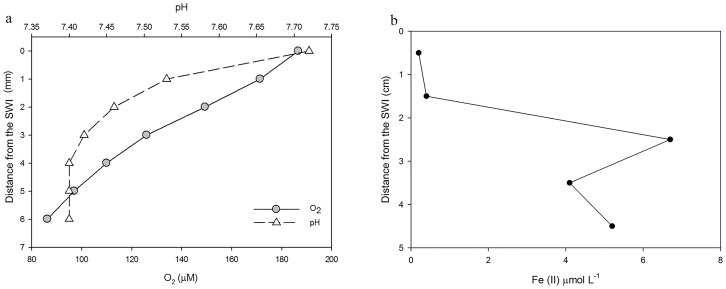
Geochemical parameters of the sampled sediments.a) pH and O2 profiles next to the sediment-water interface in the core collected at the depth of 567 m in Dor disturbance. b) Fe2+ profile in the same core. (pH and O2 were measured at 1 mm resolution, Fe2+ was measured at 1 cm resolution.)